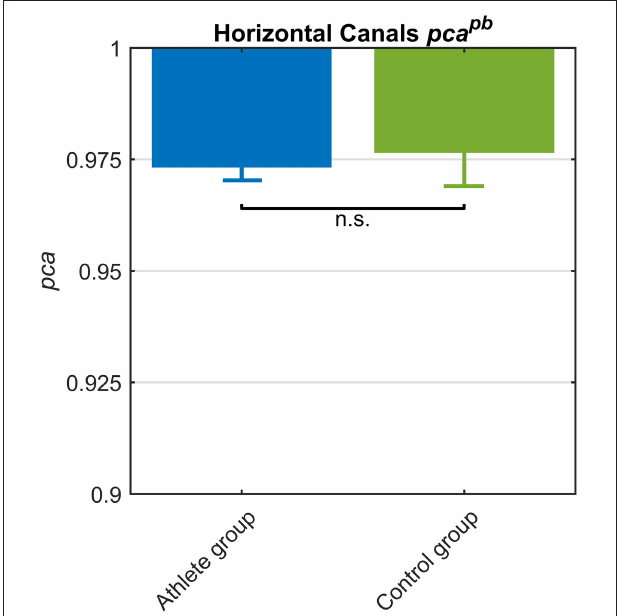
FIGURE 6 | Proportion of correct answers ( pca ) in whole athlete group (blue) and control group (green). The two pca for the impulses performed in the plane of the horizontal canals were computed using the pooled approach (Equation 1) considering only head movements in the range of 2,001–6,000 deg/s 2 . Confidence intervals for pca were estimated as in Figure 3 . The whole athlete group and control group showed a comparable performance for impulses performed in the horizontal canals, as showed by the overlapping c.i.. Accordingly, the pca were revealed no significant (n.s.) different by Zeta test (see section Results).